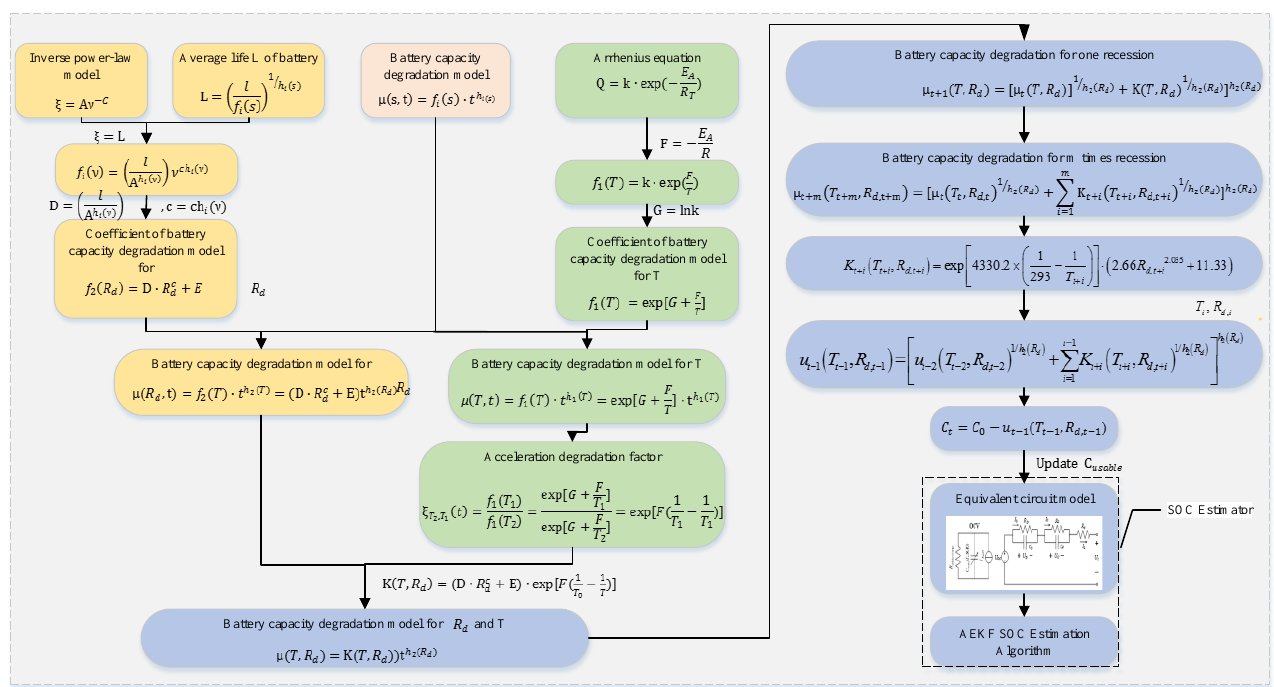
Figure 4. SOC estimator based on updating the battery capacity. AEKF: Adaptive Extended Kalman filter.